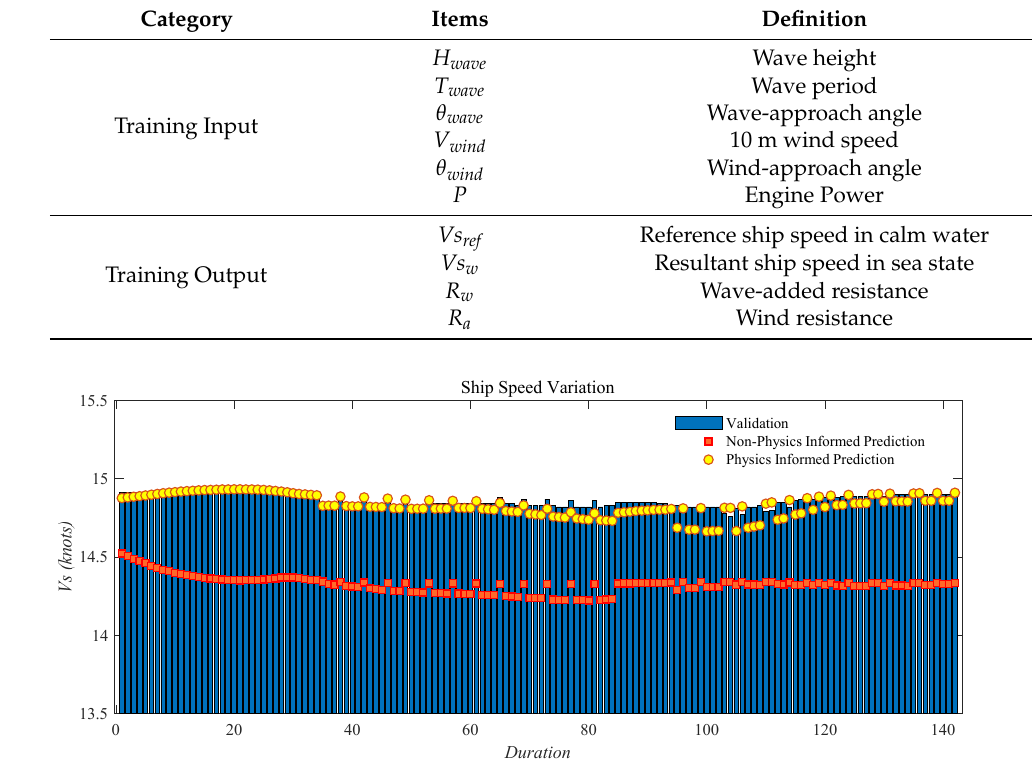
Figure 16. Validation of ANN prediction of resultant ship speed.